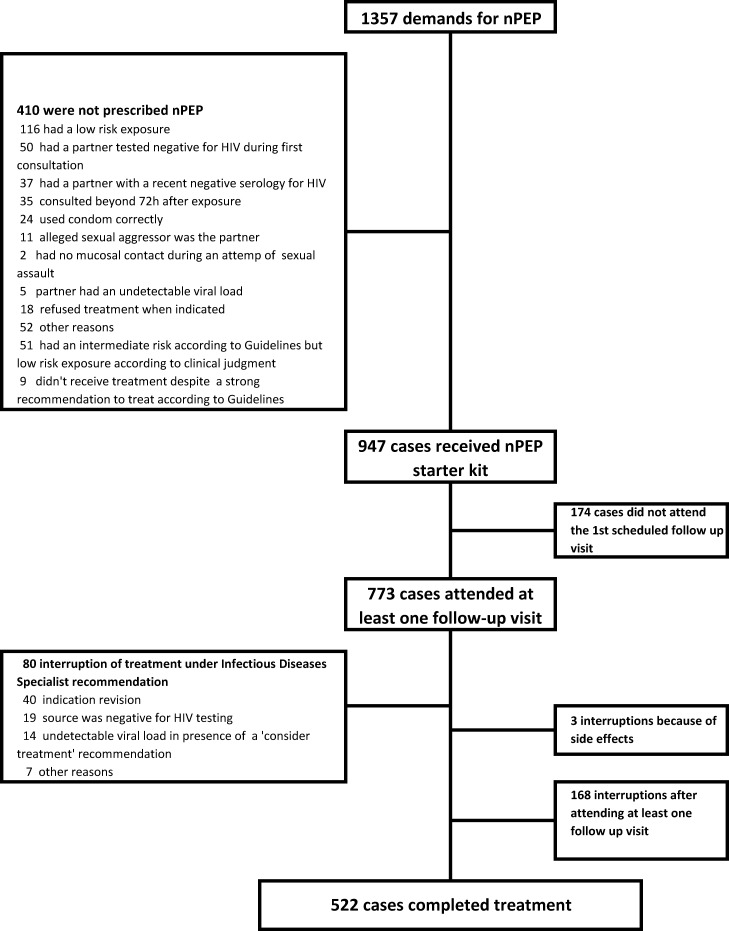
Study flow diagram.